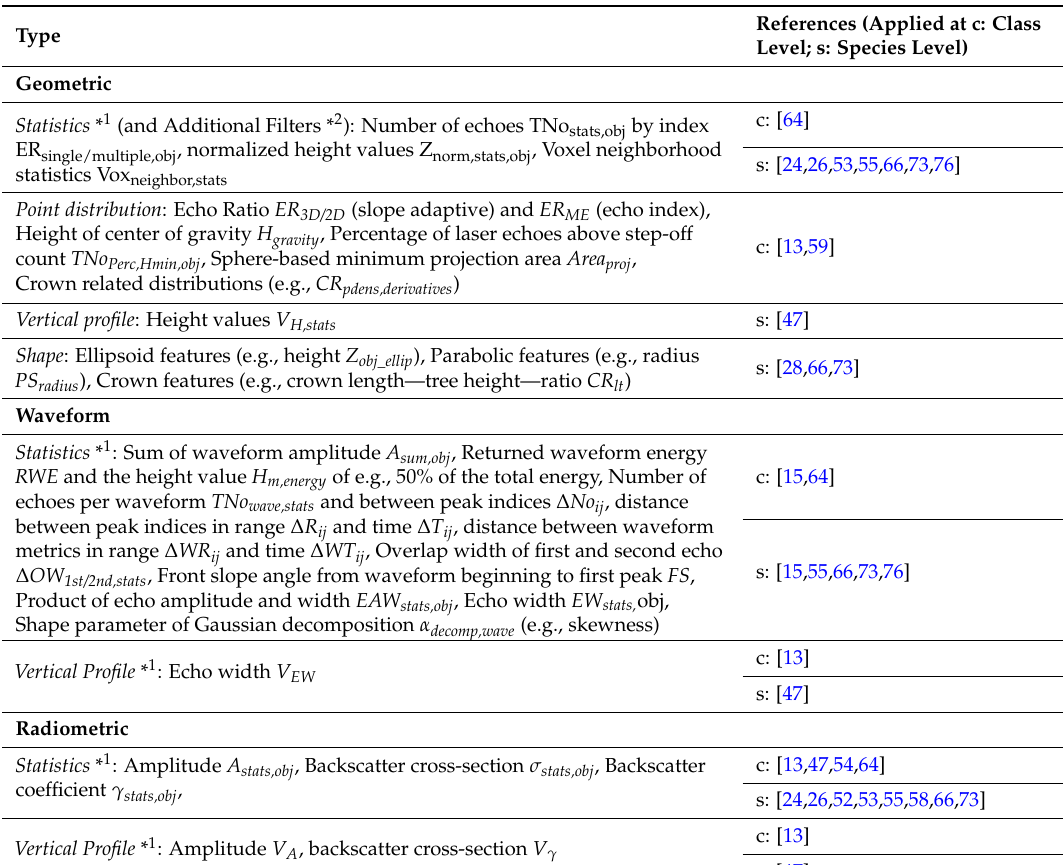
Table 2. Object features for classification differentiated by geometric, waveform and radiometric feature types and related to studies at taxonomic class and species